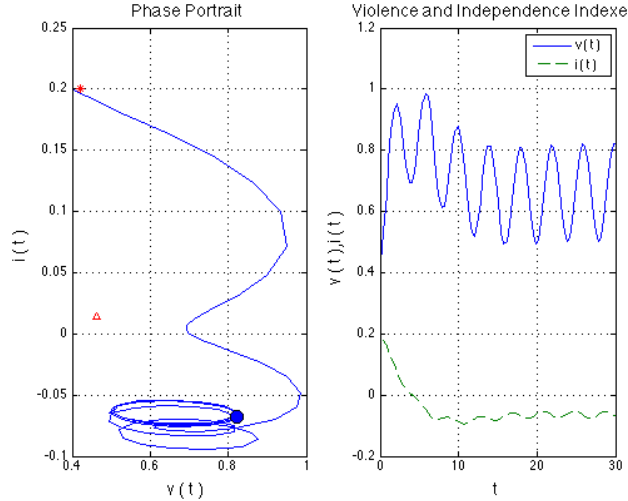
Figure 4. Violent man with alcohol consumption, non-independent woman. α 1 = 0.7, α 2 = 0.6, β 1 = 0.6, β 2 = 0.5, γ = 0.5, δ 1 = 0.2, δ 2 = 0.25, ρ 1 = 0.5, ρ 2 = 0.5, µ = − 0.2, ρ = 0.25, ω = π /2, η = 0.35.